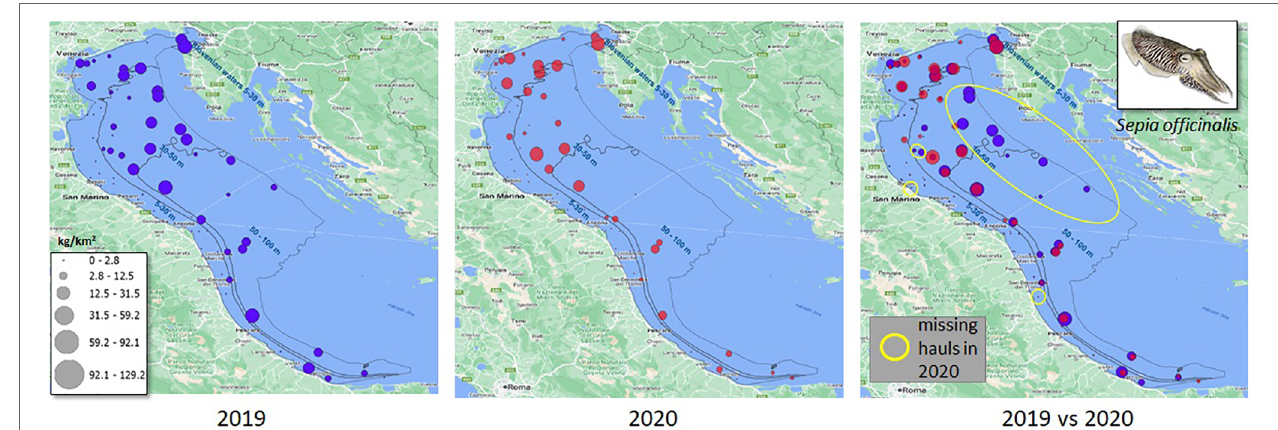
FIGURE 2 | Explanatory example of our model’s scope, i.e., estimating stock biomass-index ( Sepia officinalis , in the example) in the hauls missed by the SoleMon programme surveys in 2020. The depth strata used by the total biomass index calculation are also